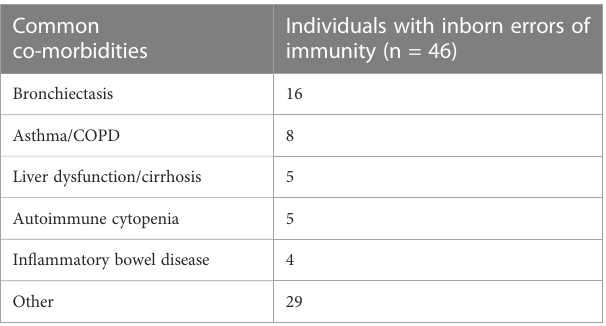
TABLE 2 Common co-morbidities of the individuals with inborn errors of immunity.